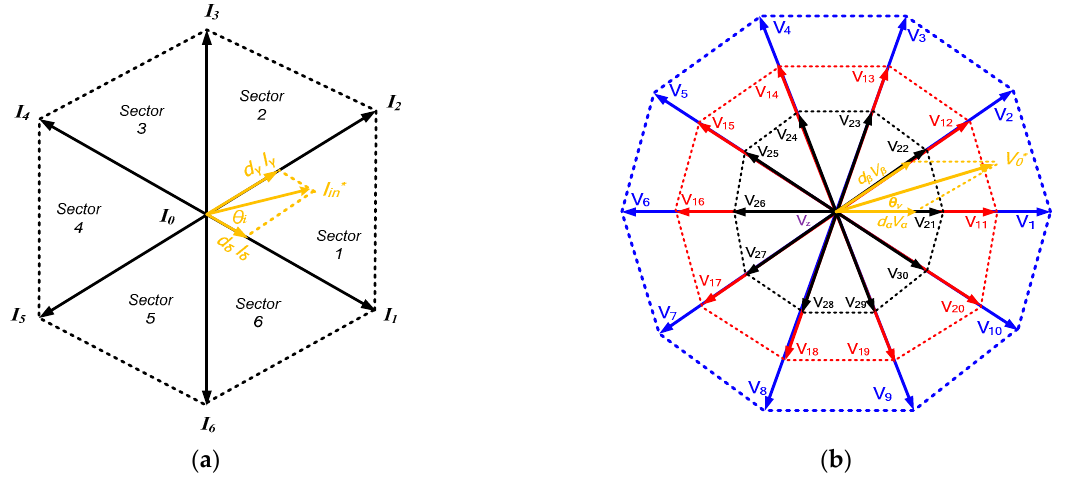
Figure 5. ( a ) Hexagon of the controlled rectifier and ( b ) decagon of the five-phase inverter. The zero-vectors were disregarded during the rectifier-stage modulation in order to obtain the highest DC-link voltage. As a result, the switching sequence is simply made up be defined in the first sector as in (14) and (15)